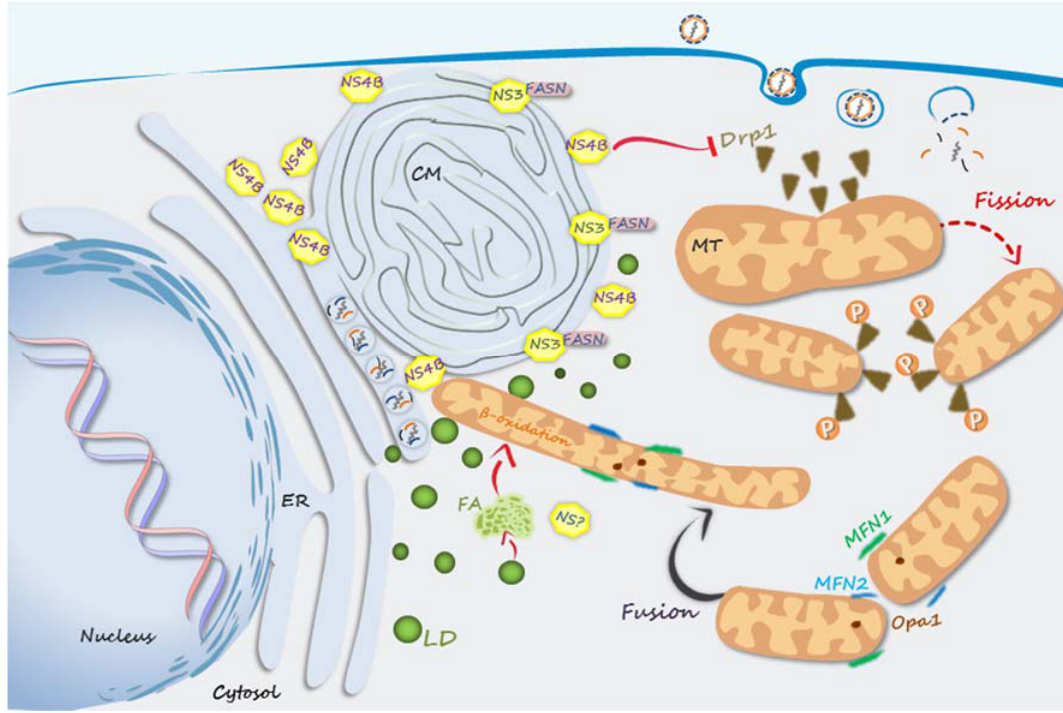
Figure 3. DENV NSPs-induced host metabolic alterations. During infection, DENV NS4B induces the formation of the convoluted membrane (CM), the membranous structure where viral polyprotein is processed and the resulting proteins accumulate. NS3 recruits the enzyme fatty acid synthase (FASN) to the virus replication sites, besides stimulating its enzymatic activity, increasing de novo FA biosynthesis, which provides lipids for inducing the formation of CM, as well as for the assembly of the viral envelope. Fatty acids (FA) are mobilized from lipid droplets (LD) to undergo β -oxidation mitochondria, providing energy to the high-energy demanding virus replication process. NS4B is able to inhibit phosphorylation of cytoplasmic protein dynamin-related protein 1 (Drp1), preventing the mitochondrial fission process. Fused mitochondria accumulate in infected cells, increasing the efficiency of the oxidative metabolism. Red arrows represent the events induced by NSPs, while dashed red arrows represent those ones that are blocked by NSPs. MFN1, mitofusin 1; MFN2, mitofusin 2; Opa1, optic atrophy protein 1; ER, endoplasmic reticulum; MT,